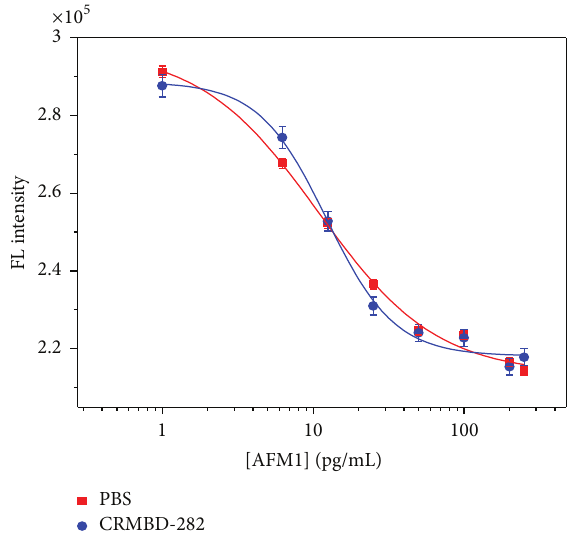
Figure 5: Calibration curve of AFM1 obtained using fluorimetric assay in buffer and CRM-BD282. 1 ∘ mAb dilution, 1:16000; FITC conjugated 2 ∘ Ab dilution, 1:64000; incubation time, 2 h; excitation time, 0.1s.